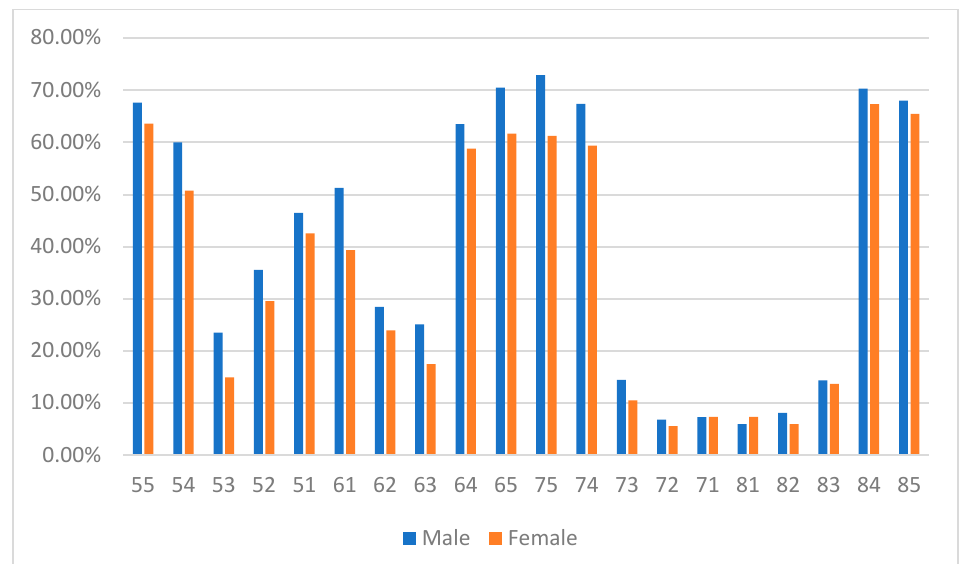
Figure 1. Distribution of dmft according to the tooth type .